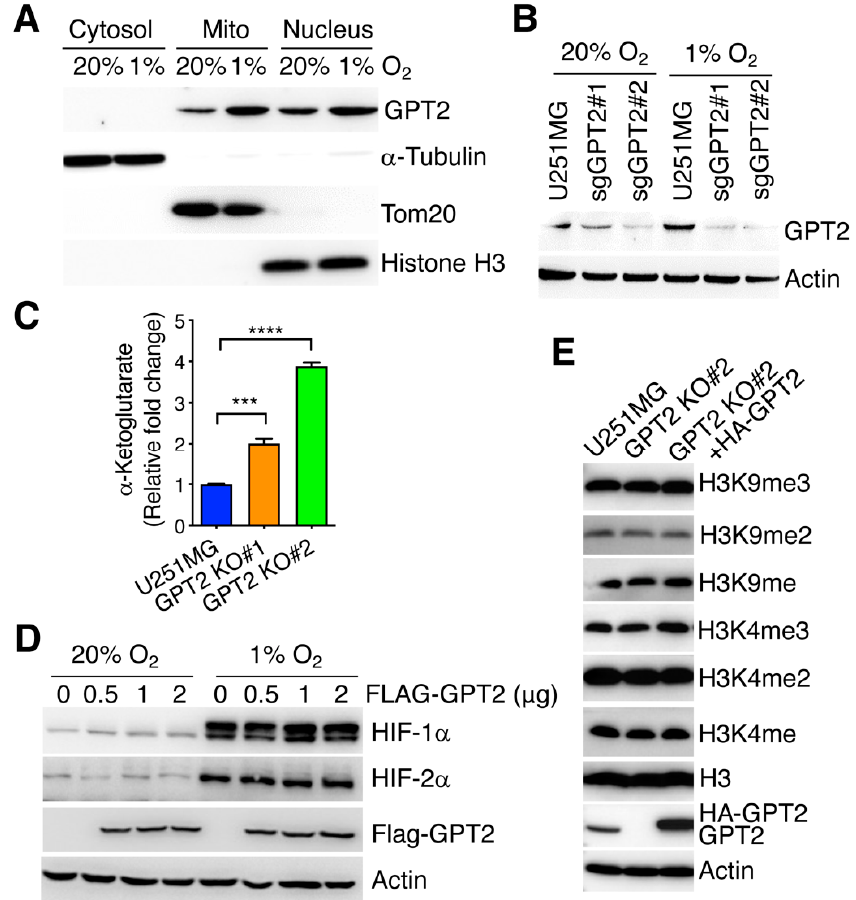
Figure 3. GPT2 has no effect on levels of HIF and histone lysine methylation. ( A ) Immunoblot analysis of indicated proteins in cytosolic, mitochondrial (mito), and nuclear fractionations isolated from U251MG cells exposed to 20% or 1% O 2 for 24 h. ( B ) Immunoblot analysis of indicated proteins in parental and GPT2 KO U251MG cells exposed to 20% or 1% O 2 for 24 h. ( C ) Quantification of intracellular α -ketoglutarate levels in parental and GPT2 KO#1 or #2 U251MG cells (mean ± SEM, n = 3). *** p < 0.001, **** p < 0.0001 by one-way ANOVA with Dunnett’s test. ( D ) Immunoblot analysis of indicated proteins in U251MG cells transfected with the different amount of FLAG-GPT2 plasmid and exposed to 20% or 1% O 2 for 6 h. ( E ) Immunoblot analysis of indicated proteins in parental, GPT2 KO#2, and GPT2 rescue U251MG cells.